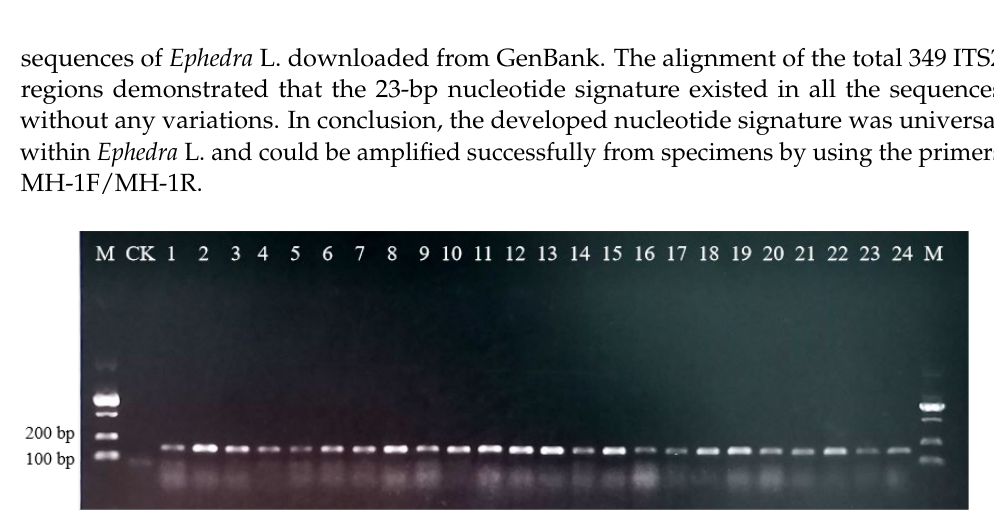
Figure 1. Amplification of 12 species and varieties in Ephedra genus with the primers MH-1F/MH-